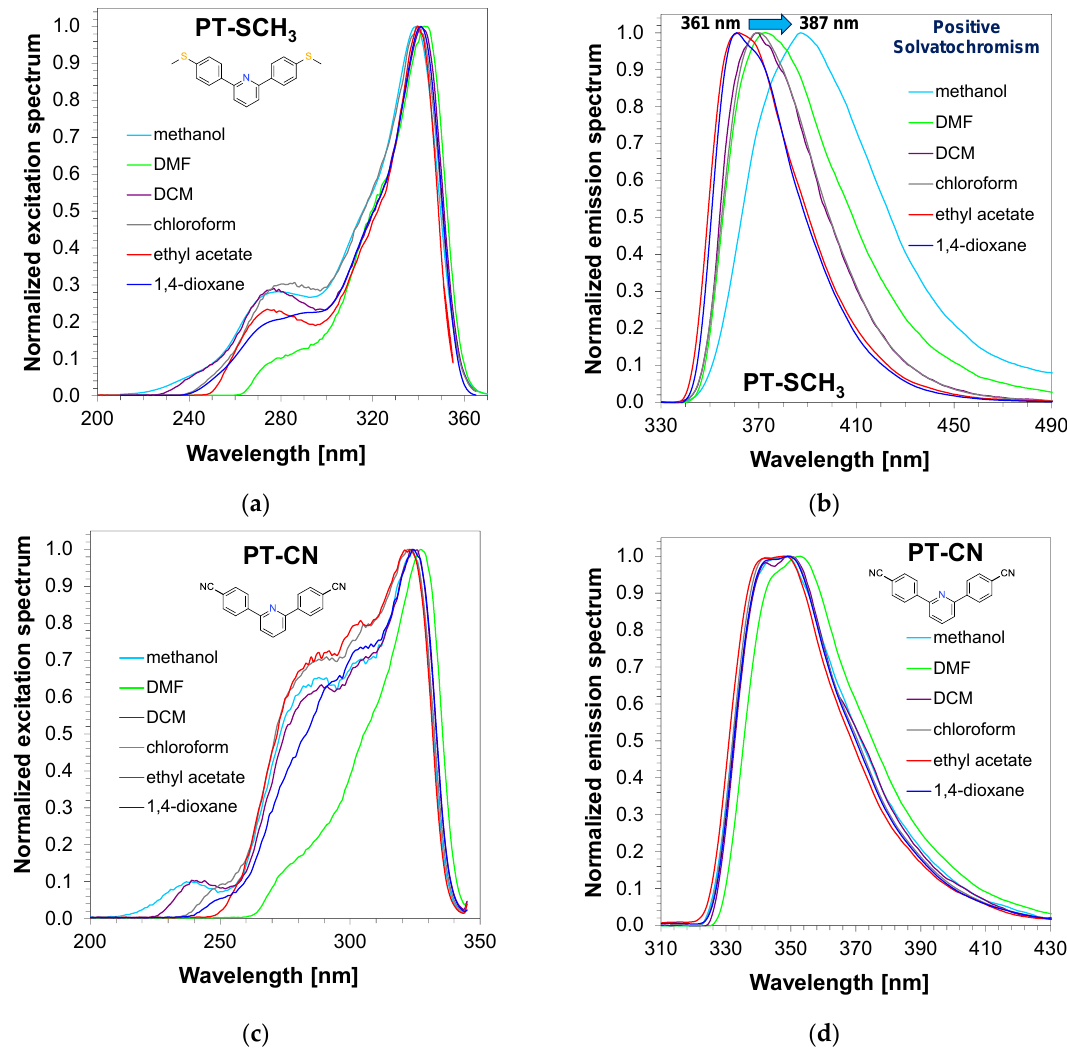
Figure 5. Spectroscopic properties of diphenylpyridine derivatives in solvents of different polarity: ( a ) normalised excitation spectrum for 2,6-bis(4-methylsulphanylphenyl)pyridine (PT-SCH 3 ); ( b ) normalised emission spectrum for 2,6-bis(4-methylsulphanylphenyl)pyridine (PT-SCH 3 ); ( c ) normalised excitation spectrum for 2,6-bis(4-cyanophenyl)pyridine (PT-CN); ( d ) normalised emission spectrum for 2,6-bis(4-cyanophenyl)pyridine (PT-CN). Table 3. Summarised data on excitation and emission spectra of PT-SCH 3 and PT-CN